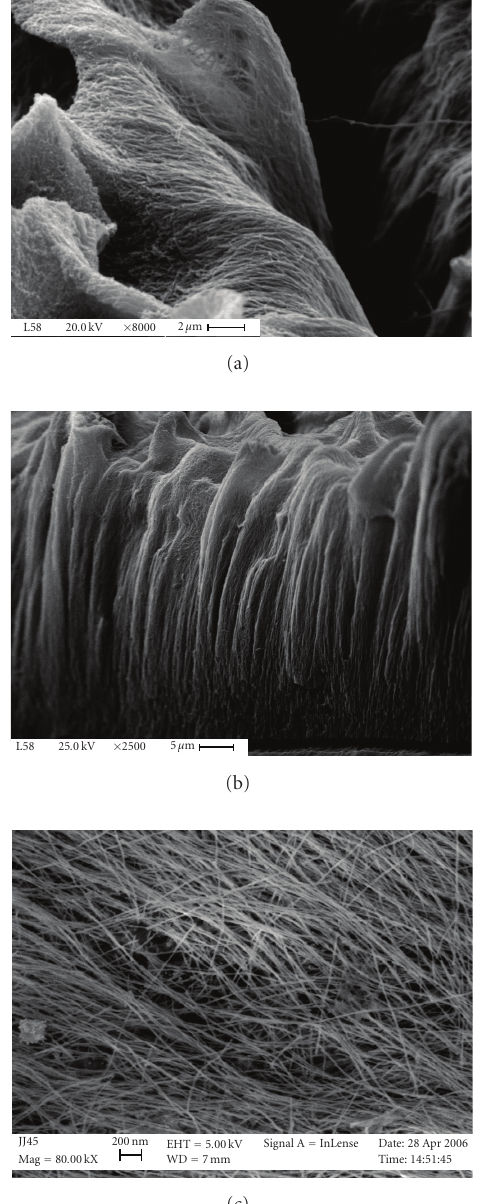
Figure 7: Top view SEM images of Co nw arrays after dissolution of oxalic acid alumina template (a, b) in part and (c) fully. Template fabrication: anodizing 3 hours; U a ,fin 5.0 V; τ w 30 minutes in 0.5 M H 3 PO 4 . Following the detachment of alumina from the substrate and a back-side evaporation of a Cr/Au layer, the deposition of Co was conducted in the solution: 0.45 cosO 4 , 0.7 M H 3 BO 3 , and TEA up to pH 5.7 at a constant DC current density of 0.12 mA cm − 2 for